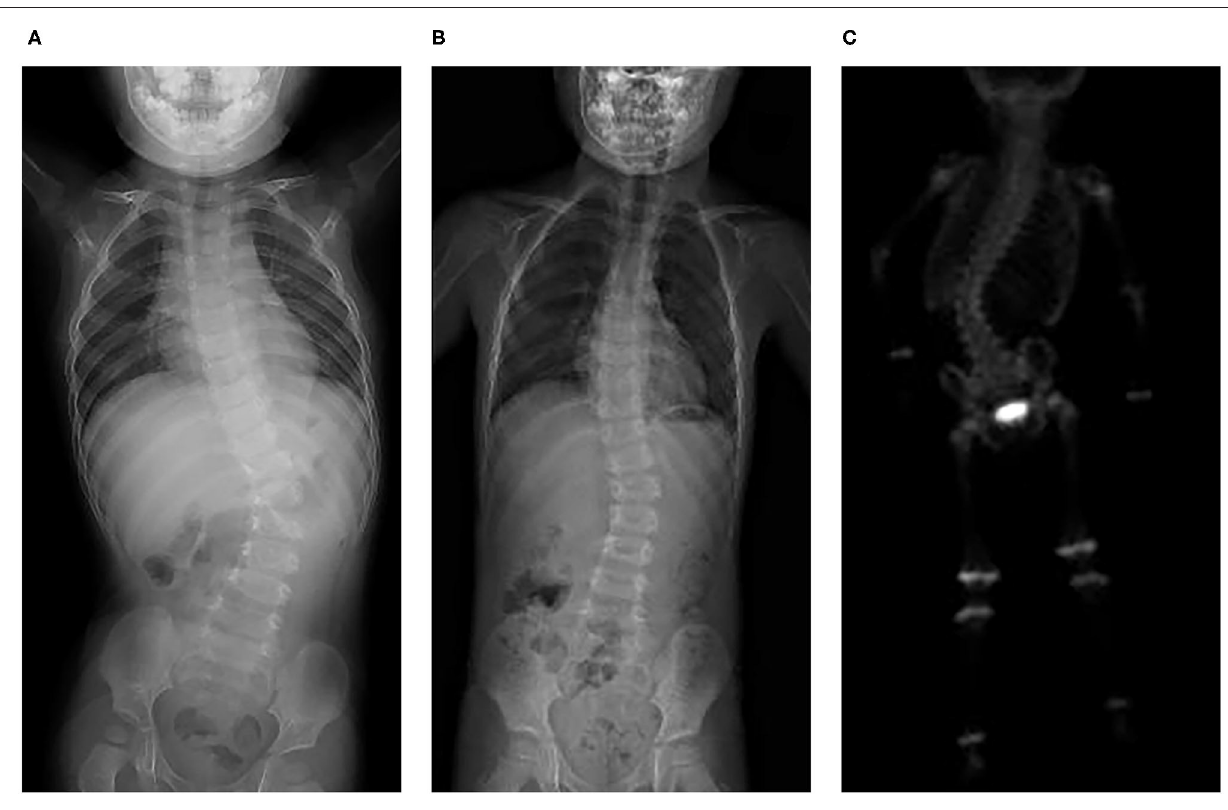
FIGURE 2 | KHE in Patient 2: X-ray showed slight scoliosis (A) , and the angle of the scoliosis was reduced after 3 years of treatment and follow-up (B) . Three hours after 99 mTc-MDP 10 mCi was injected intravenously, a whole-body bone scan was performed. It also showed scoliosis and slightly increased radioactive distribution on the right edge of the T12-L2 vertebral body (C)